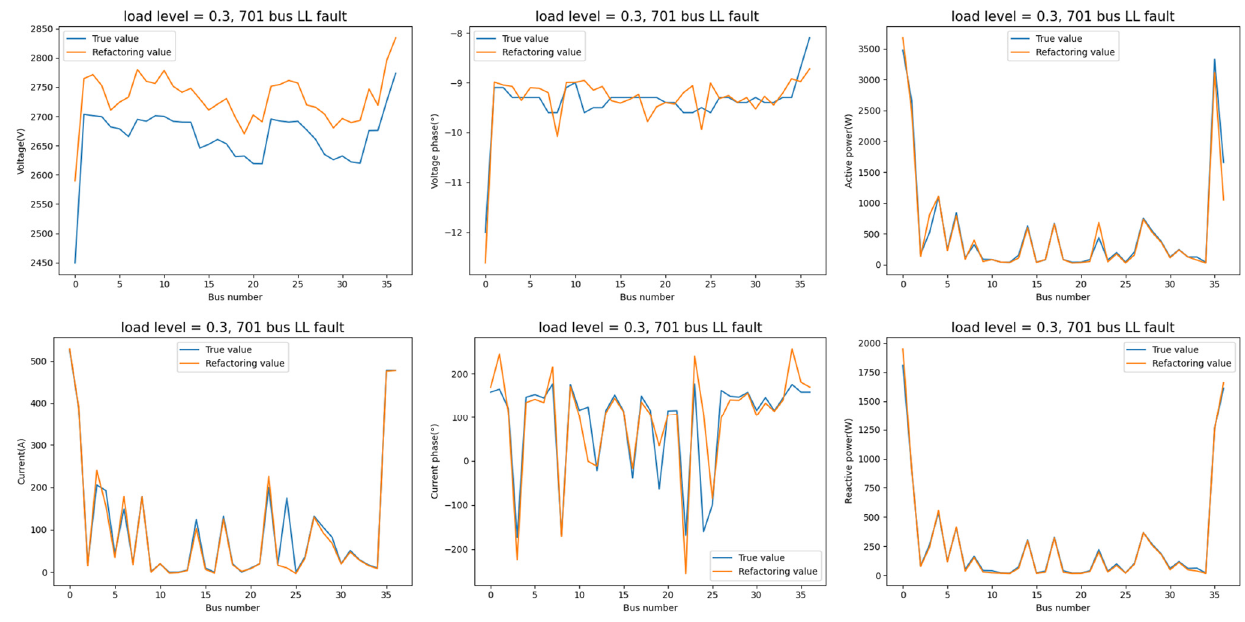
Figure 7. Some feature reconstruction results based on the proposed SR method.